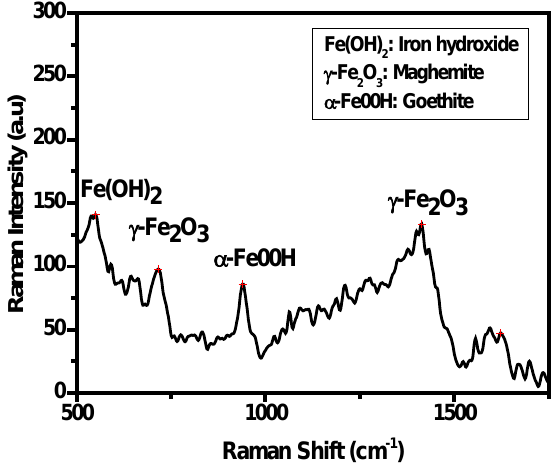
Figure 8. Raman shifts of corrosion products from MAS in simulated E80 fuel ethanol showing the presence of iron hydroxide, maghemite and goethite.